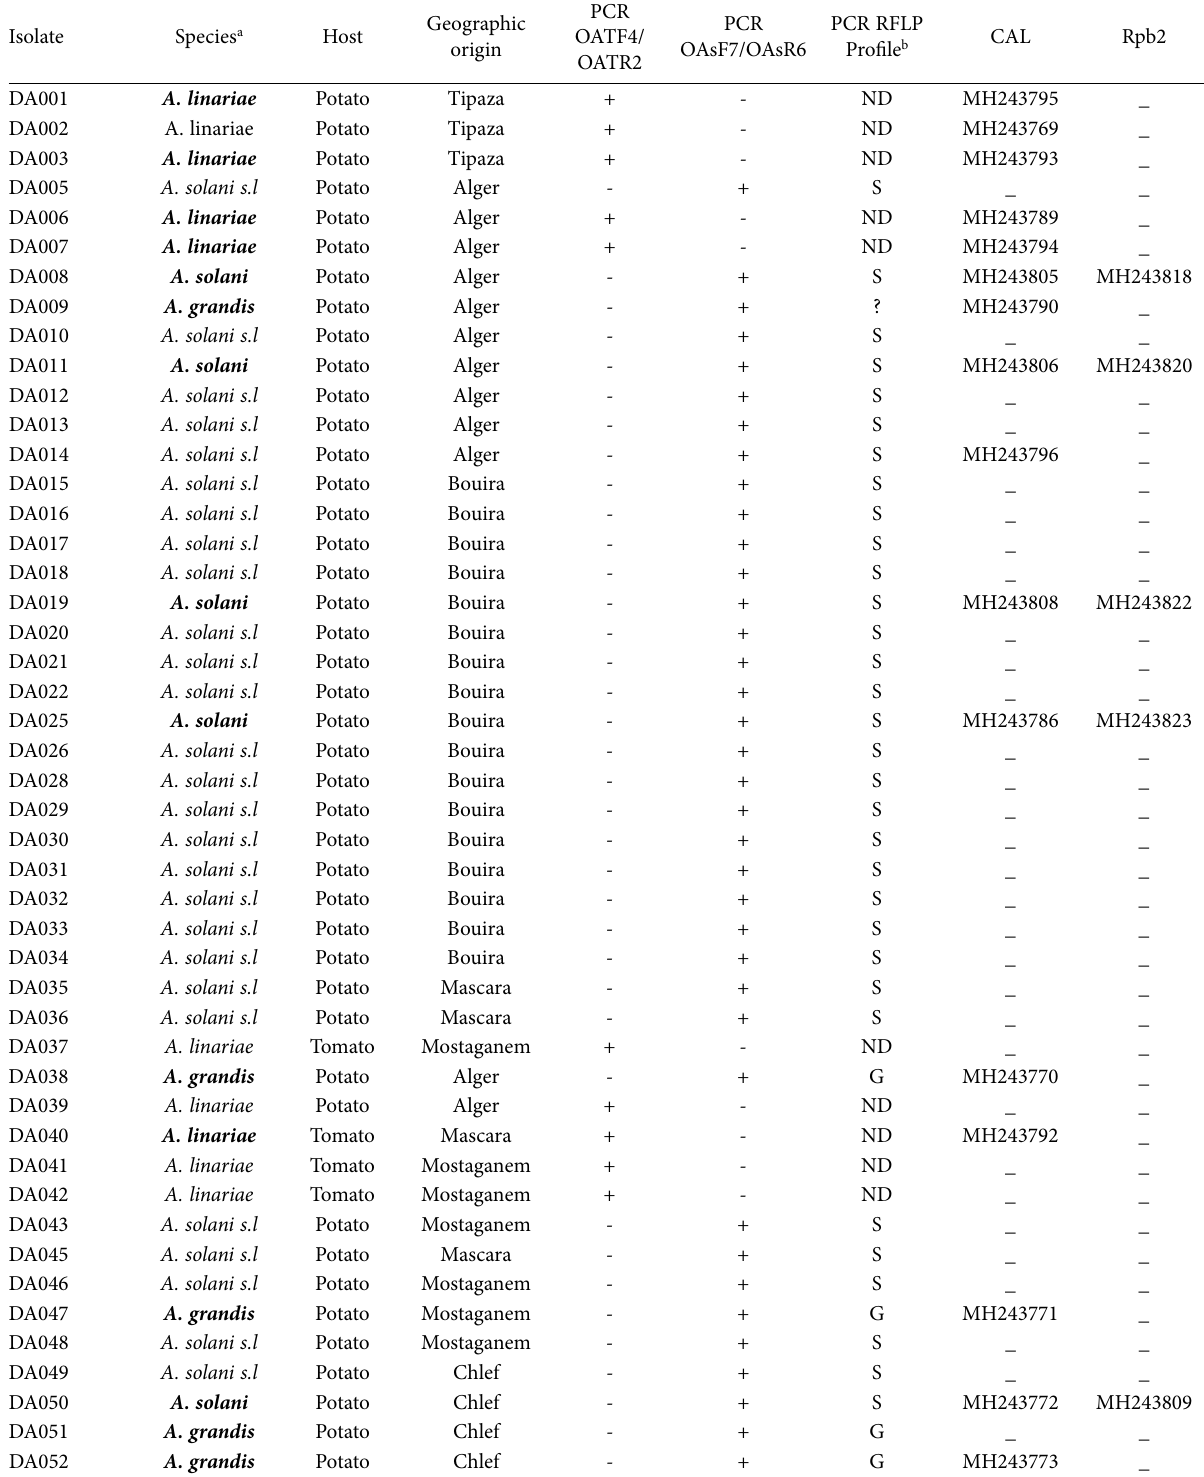
Table 1. Identification of large-spored of Alternaria spp isolates.